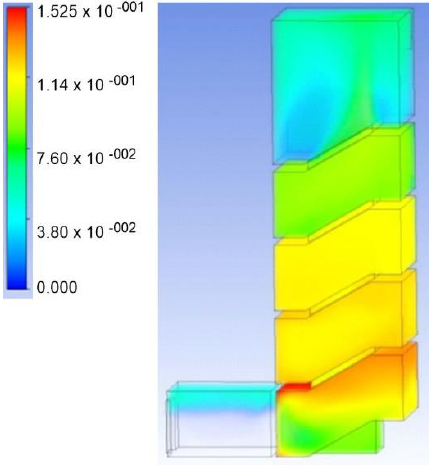
Figure 4. Carbon dioxide distribution 12 s after the door was opened. Carbon dioxide was meas- ured as a mass fraction.